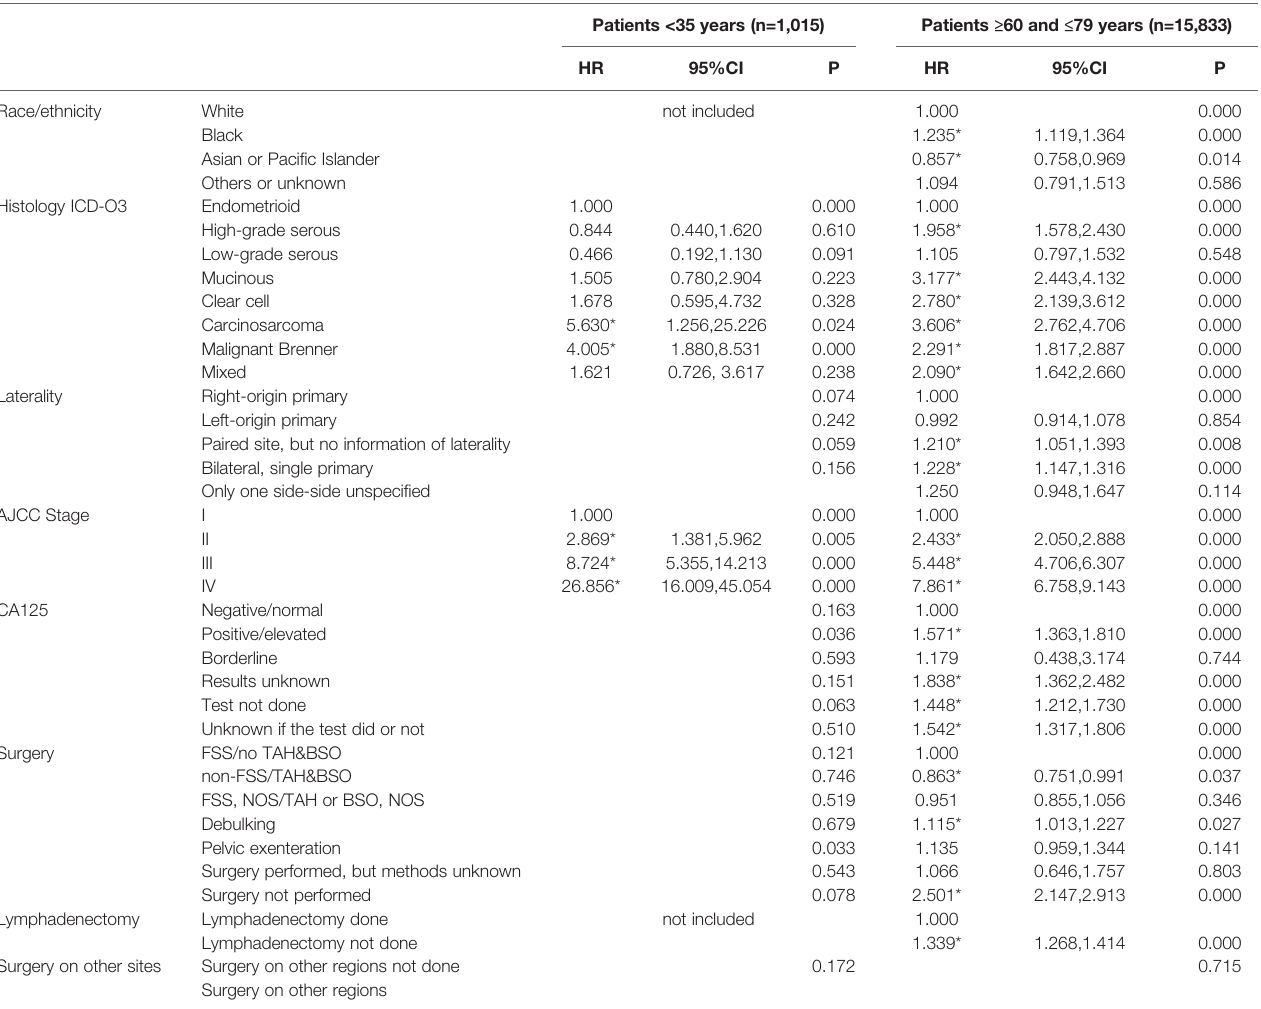
TABLE 4 | Multivariate analysis by Cox regression for CSS in both young and old women group with epithelial ovarian cancer in 2004 – 2015, SEER 18 registries. Patients <35 years